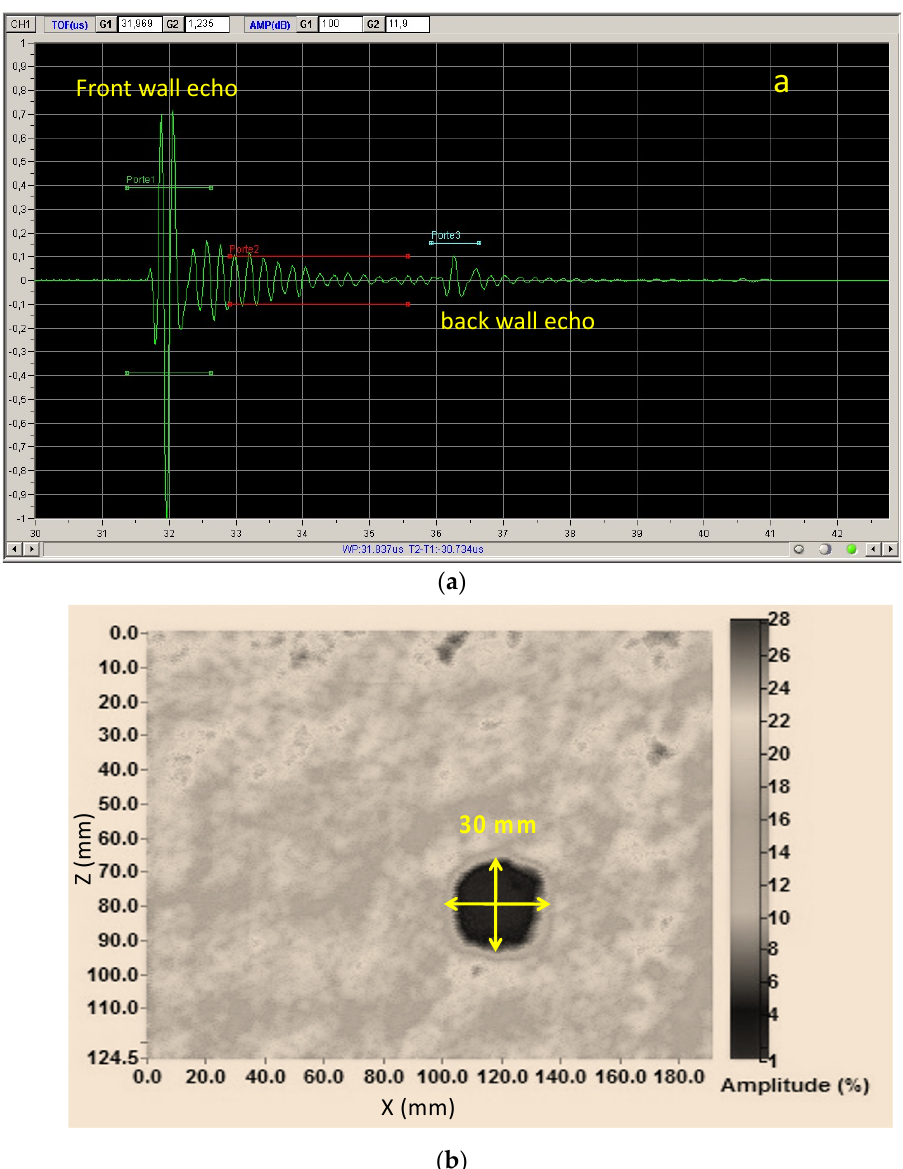
Figure 4. ( a ) A-Scan signals corresponding to the reflection of a longitudinal ultrasonic wave at the defect position of the impacted CFRC plate; ( b ) C- Scan image based on the A-scans performed at intact and damaged regions of the CFRC plate. The amplitude of the back-wall echo is strongly decreasing in the damaged area. The damage was found to be ~30 mm wide.